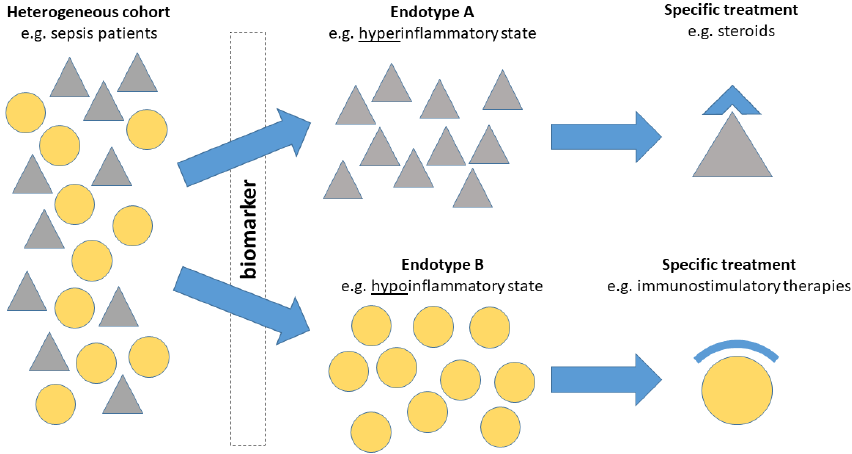
Figure 2. Biomarker-enrichment approach (compare Wong et al.